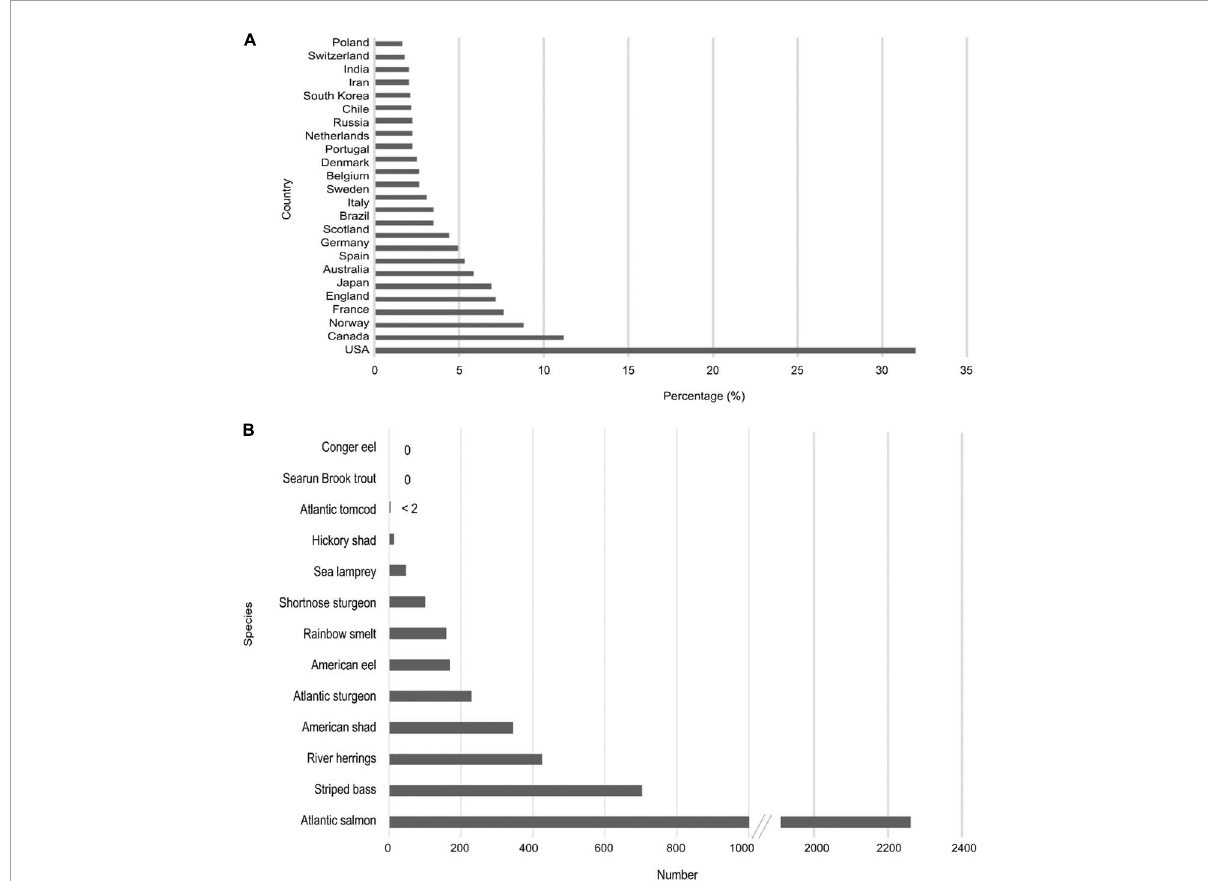
FIGURE2 Web of Science data for publications involving diadromous species between 2010 and 2020 showing (A) percentage of published literature per country and (B) the number of publications by species for the East Coast